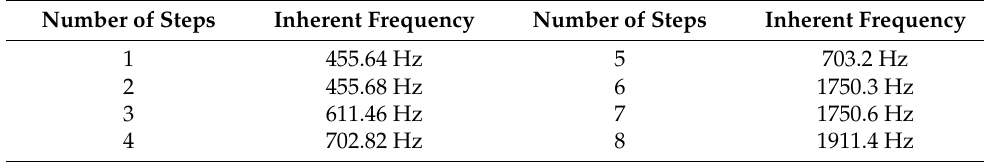
Table 5. The first 8 order natural frequencies of impeller rotor in case B.